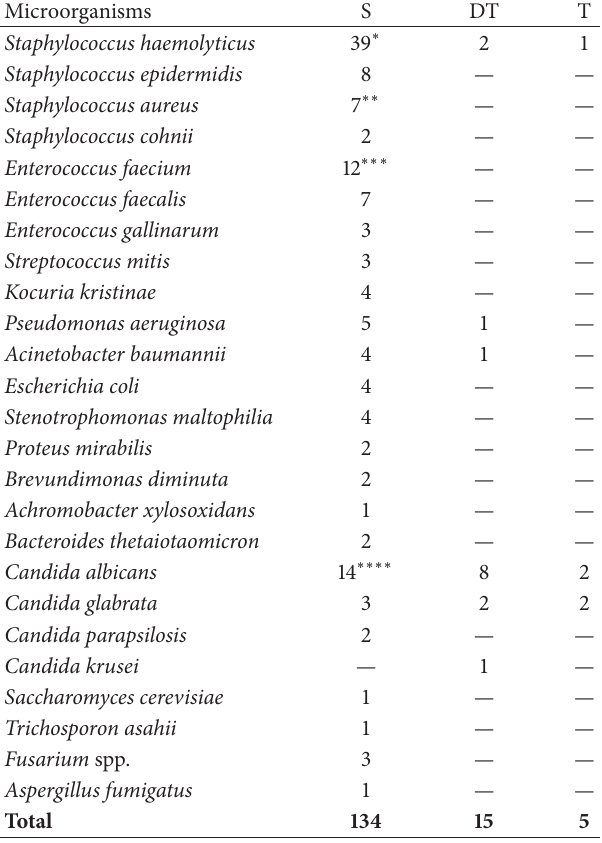
Table 3: Microorganisms isolated in different